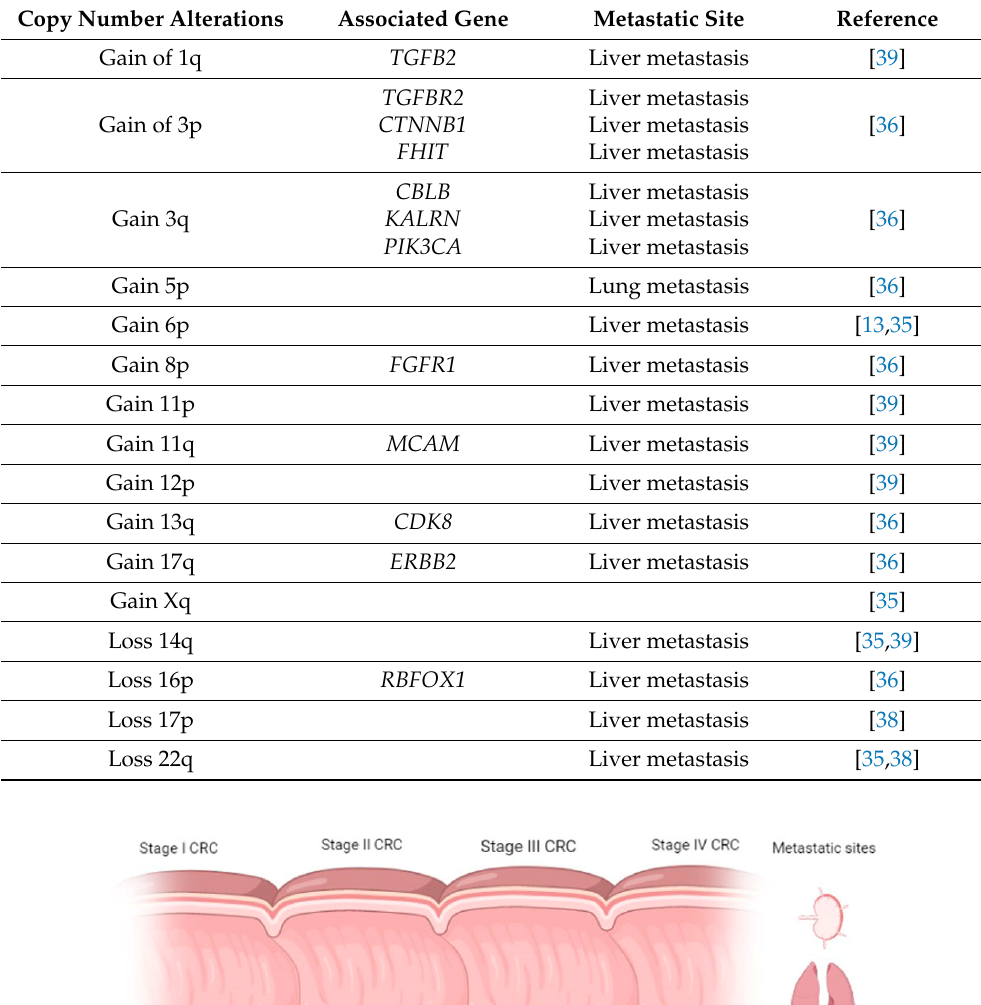
Table 2. The most common chromosomal alterations and their associated genes are involved in carcinoma to metastatic progression. Liver and lung tend to be the most common metastatic sites and are also characterized by different gains and losses.